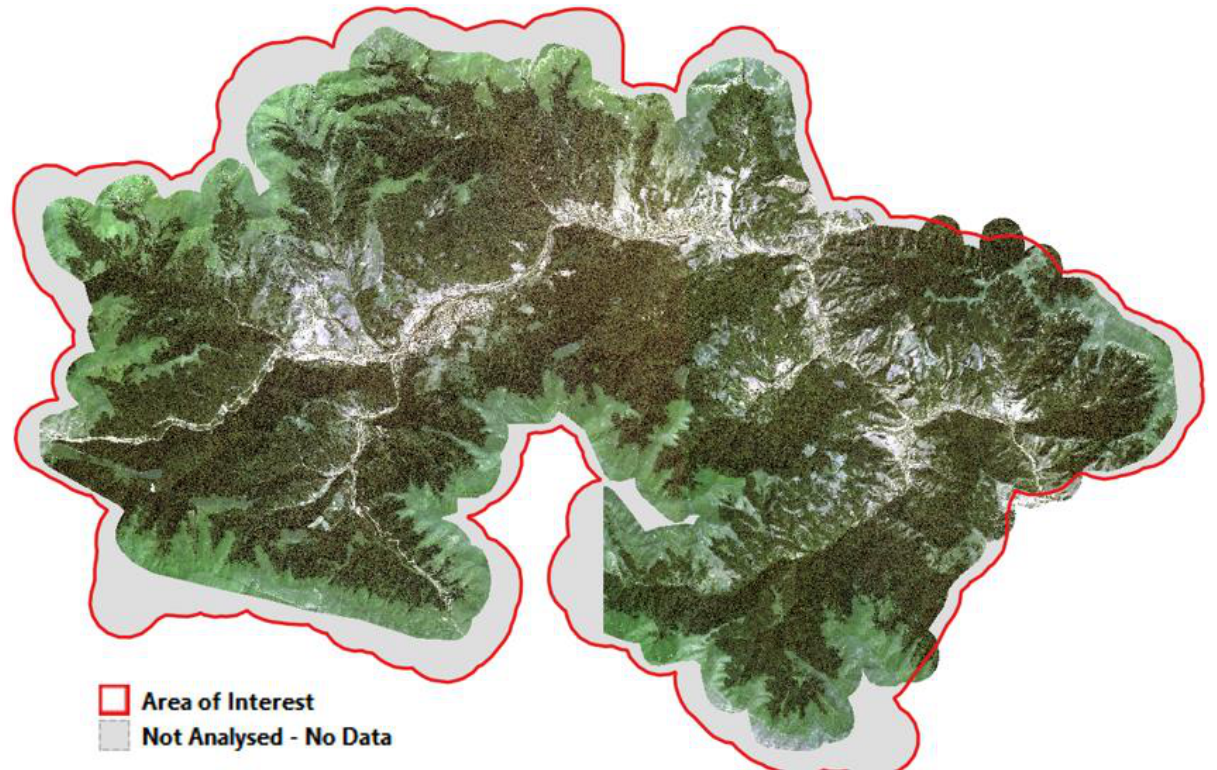
Figure 3. Pléiades at 0.5 m spatial resolution (Pansharpened) acquired on 17 and 24/07/2014@CNES (2014), Distribution AIRBUS DS.